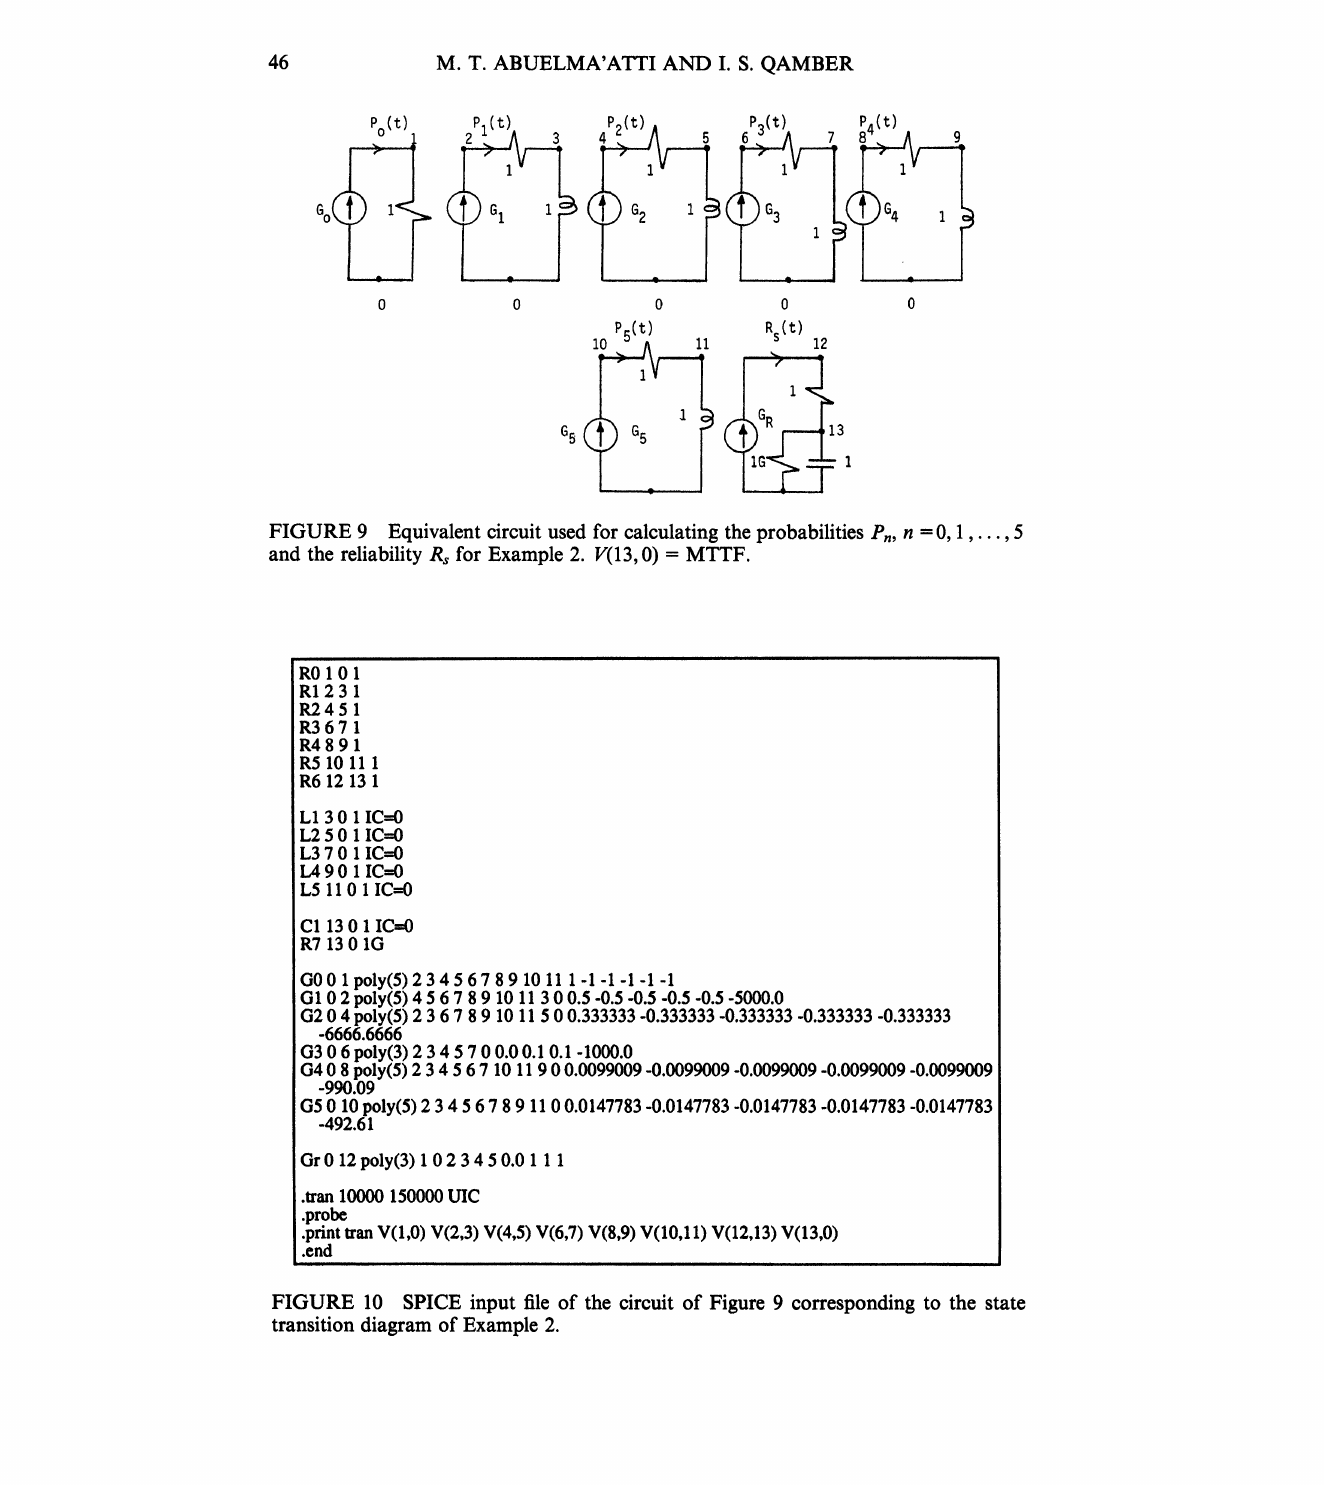
FIGURE 9 Equivalent circuit used for calculating the probabilities Pn, n =0,1 5 and the reliability Rs for Example 2. V(13, 0) MTTF.